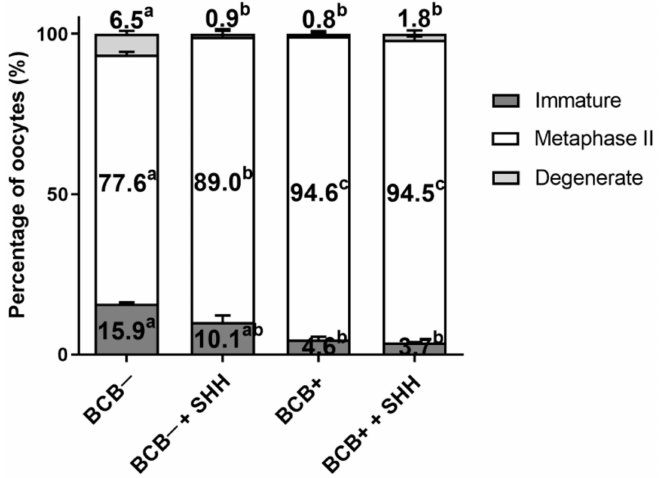
Figure 2. Effect of sonic hedgehog (SHH) protein supplementation during in vitro maturation of brilliant cresyl blue (BCB) − and BCB+ cumulus–oocyte complexes (COCs) on oocyte nuclear maturation. The experiment was independently replicated four times with at least 100 oocytes per group. Groups indicated by different letters (a–c) represent significant differences ( p < 0.05). BCB − , BCB non-stained COCs; BCB − + SHH, BCB − COCs supplemented with 0.5 µ g/mL SHH protein;